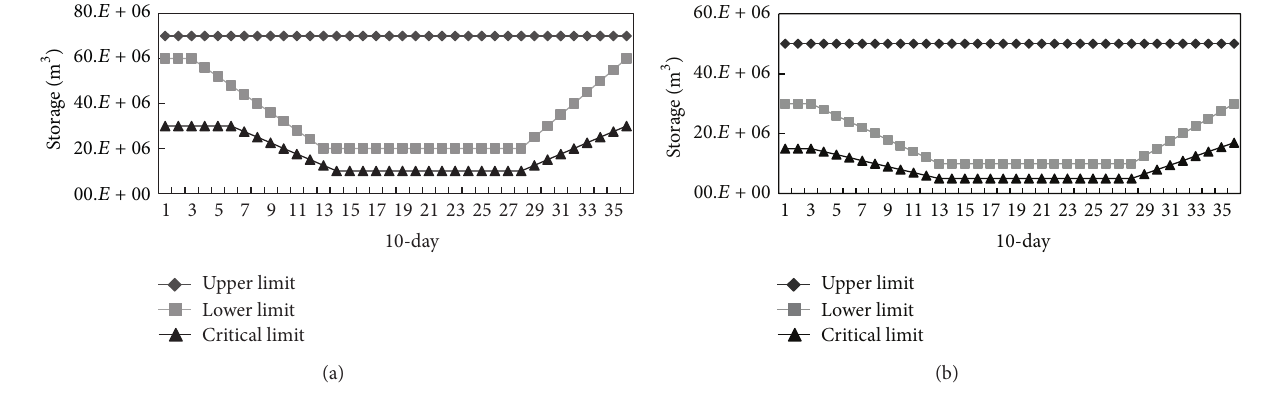
Figure 5: The operation rule curve of (a) Reservoir 1 and (b) Reservoir 2.